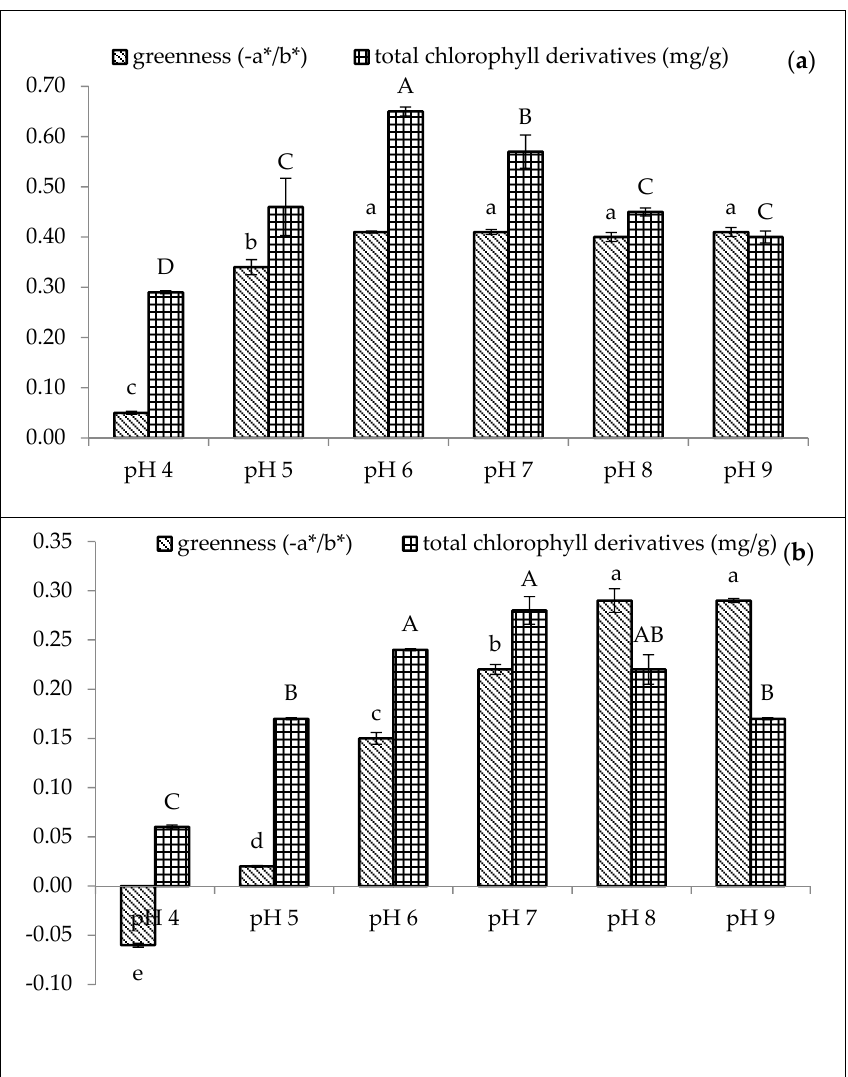
Figure 2. Effect of pH on greenness ( − a*/b*) and total chlorophyll derivative content (mg/g) in ( a ) 210 mg/L of CuSO 4 and ( b ) 1500 mg/L of ZnCl 2 stabilised amaranth purees after heating at 80 °C for 15 min. Each value is expressed as mean ± standard deviation ( n = 3) of triplicate analysis. The bars with different lowercase (a–e) and uppercase (A–D) letters indicate significant differences ( p < 0.05) in Tukey’s HSD